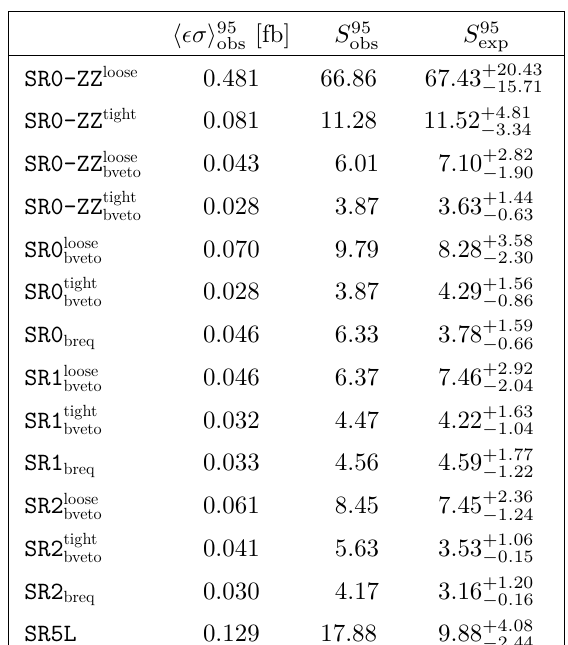
Table 10. The model-independent limits calculated from the signal region observations; the 95% CL upper limit on the visible cross-section times efficiency ( h (cid:15)σ i 95 events( S 95 ), and the signal events given the expected number of background events ( S 95 obs ations of the expected number) calculated by performing pseudo-experiments for each signal